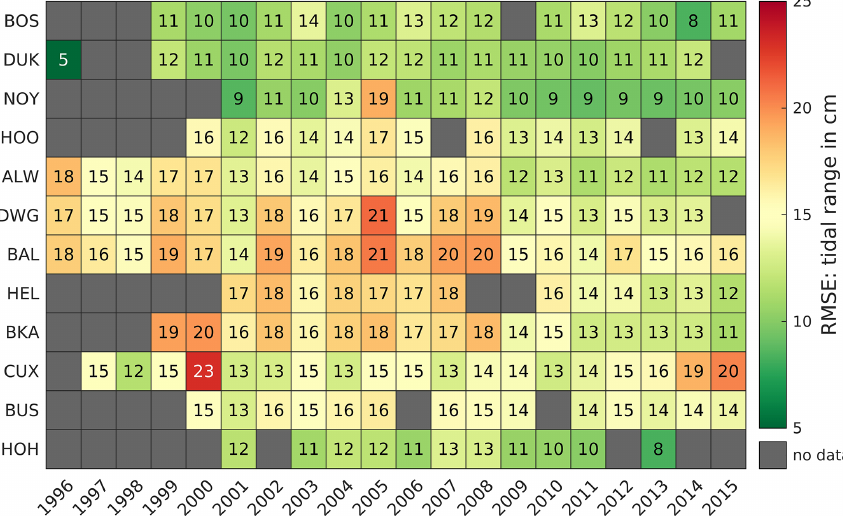
Figure 10. Root mean square error (RMSE) of the tidal range in centimeters between 1996 to 2015 at representative gauges.